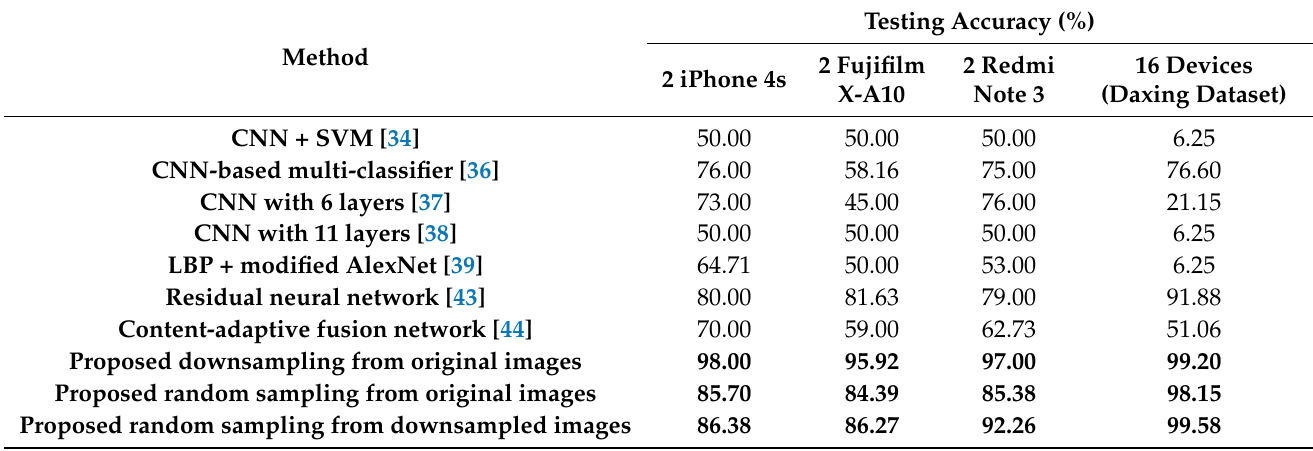
Table 5. Performance comparison of proposed methods with state-of-the-art